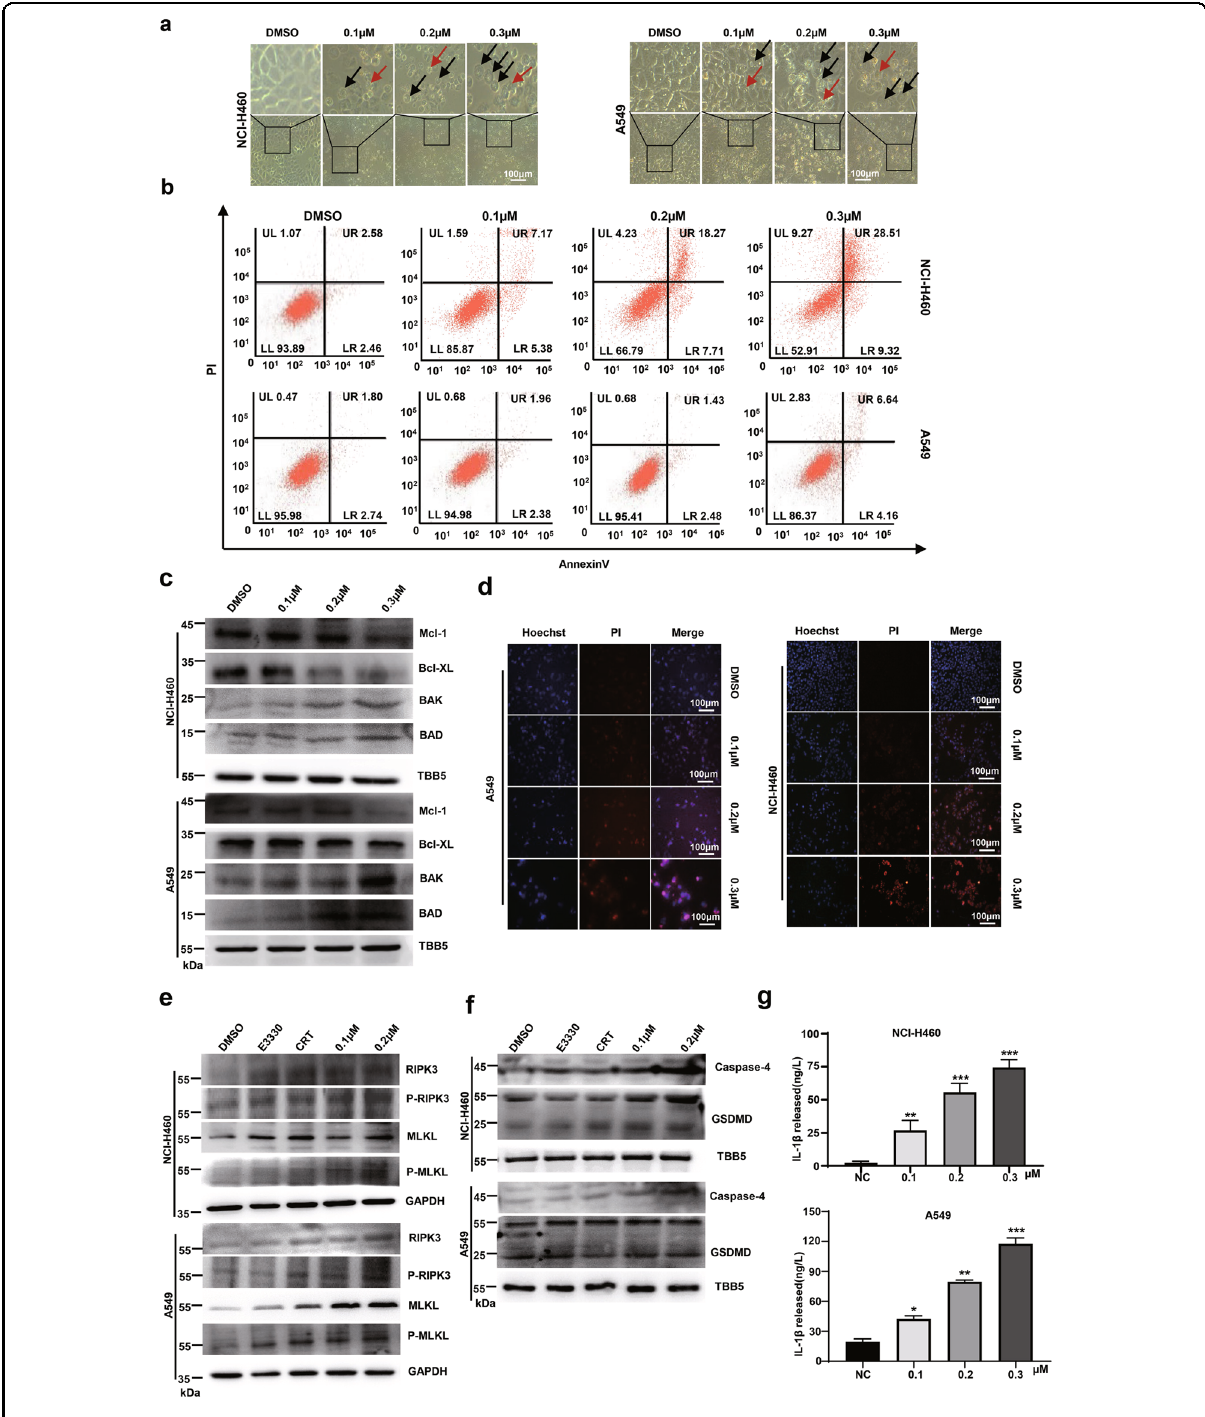
Fig. 4 NO.0449-0145 induces cell death in NCI-H460 and A549 cells. a Morphological analysis of NCI-H460 and A549 cells with different dose of NO.0449-0145 treatment for 24 h. The red arrows indicate the apoptotic bodies; the black arrows point to bubbling of cells. b Annexin V/PI staining and fl ow cytometry analysis of NCI-H460 and A549 cells with different dose of NO.0449-0145 treatment for 24 h. c Levels of BAD, BAK, Mcl-1 and Bcl- XL assessed by western blotting for the cells treated with NO.0449-0145 for 12 h. d Representative Hoechst/PI fl uorescence images of cells with different treatment. e Western blotting analysis of basic RIPK3, MLKL, phosphorylation of RIPK3 (P-RIPK3), and MLKL (P-MLKL) in A549 and NCI-H460 cells. f Western blotting analysis of caspase-4 and GSDMD in A549 and NCI-H460 cells. g Secreted IL-1 β from cells treated with NO.0449-0145 for 24 h. Each experiment was repeated three times. The signi fi cance between treated samples and control samples was determined using a t- test. * p < 0.05; ** p < 0.01; *** p <